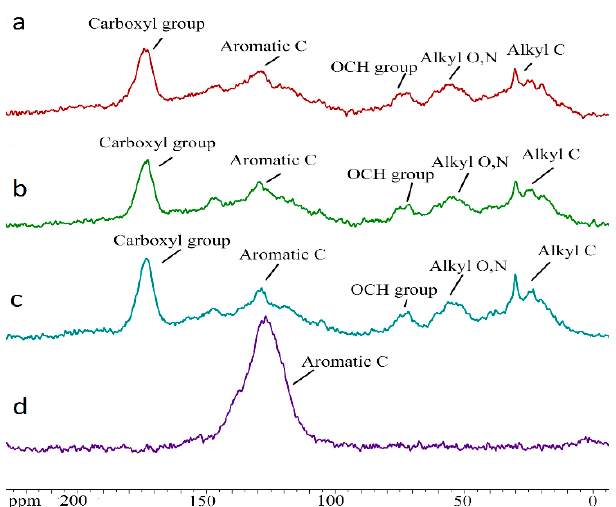
Figure 4. CPMAS 13 C-NMR spectra HAs humic acids formed during the decomposition of plant residues of clover, 90 days of composting (( a )—control; ( b )—CaCO 3 ; ( c )—biochar; ( d )—initial biochar).